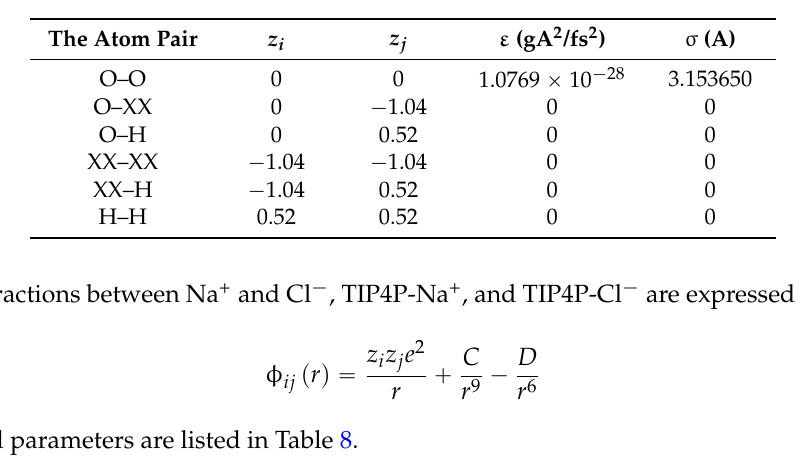
Table 7. The potential parameters for TIP4P.